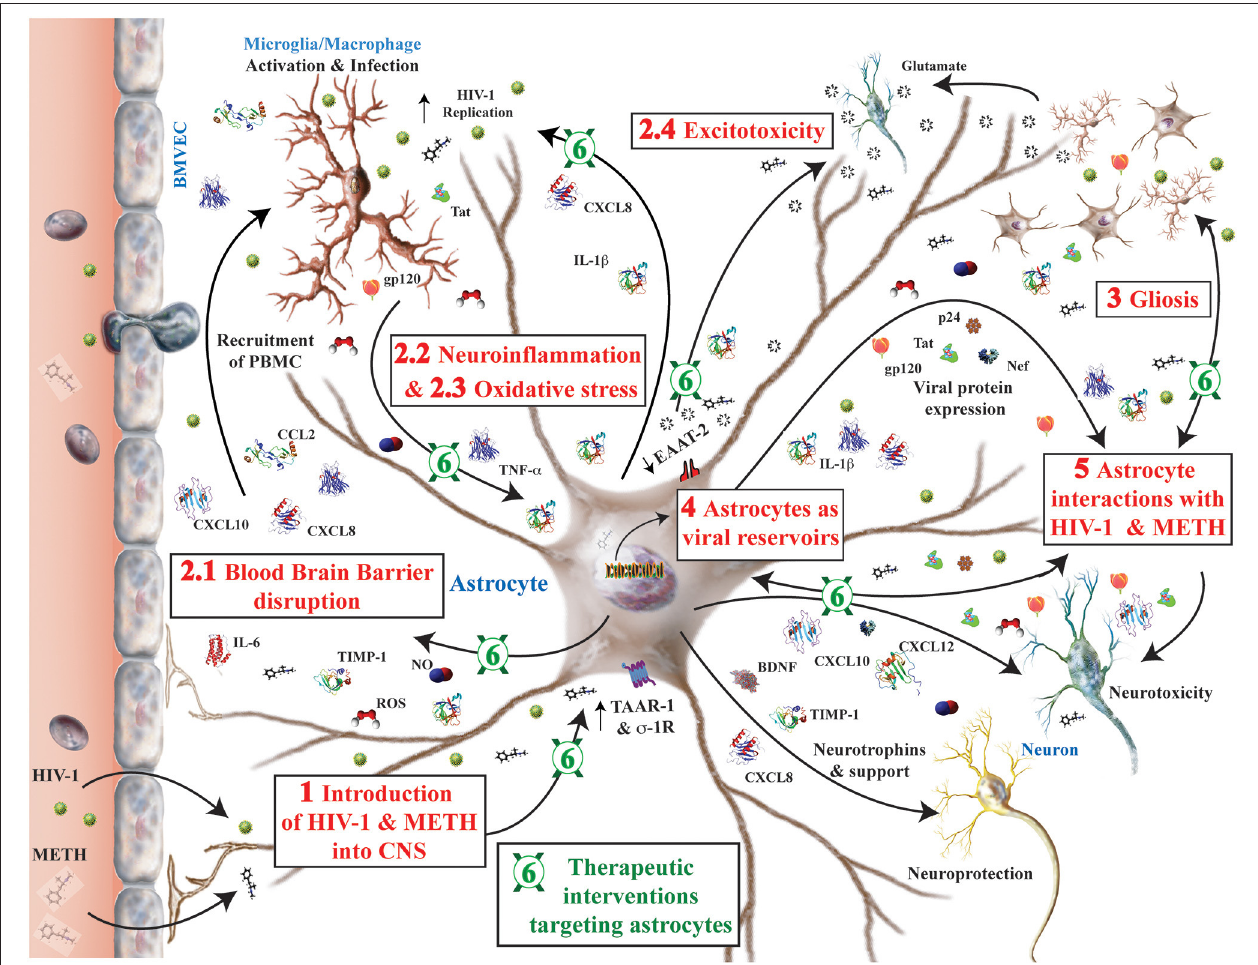
FIGURE 1 | An interactive neuroinflammatory roadmap crosslinking astrocytes with HIV-1 and METH. The crystal structures of cytokines created using the data from Protein Data Bank (:PBD) for CCL2:1dok, CXCL8: 1IL8, CXCL10: 1o7z, CXCL12:1a15, IL-1 β : 31BI, IL-6: 1ALU, TIMP-1: 1d2b TNF- α : 1TNF were rendered using PyMOL Molecular Graphics System (Schrödinger, LLC); BDNF: 1bnd, METH, ROS, NO were rendered using Accelrys Software (BIOVIA, San Diego, CA